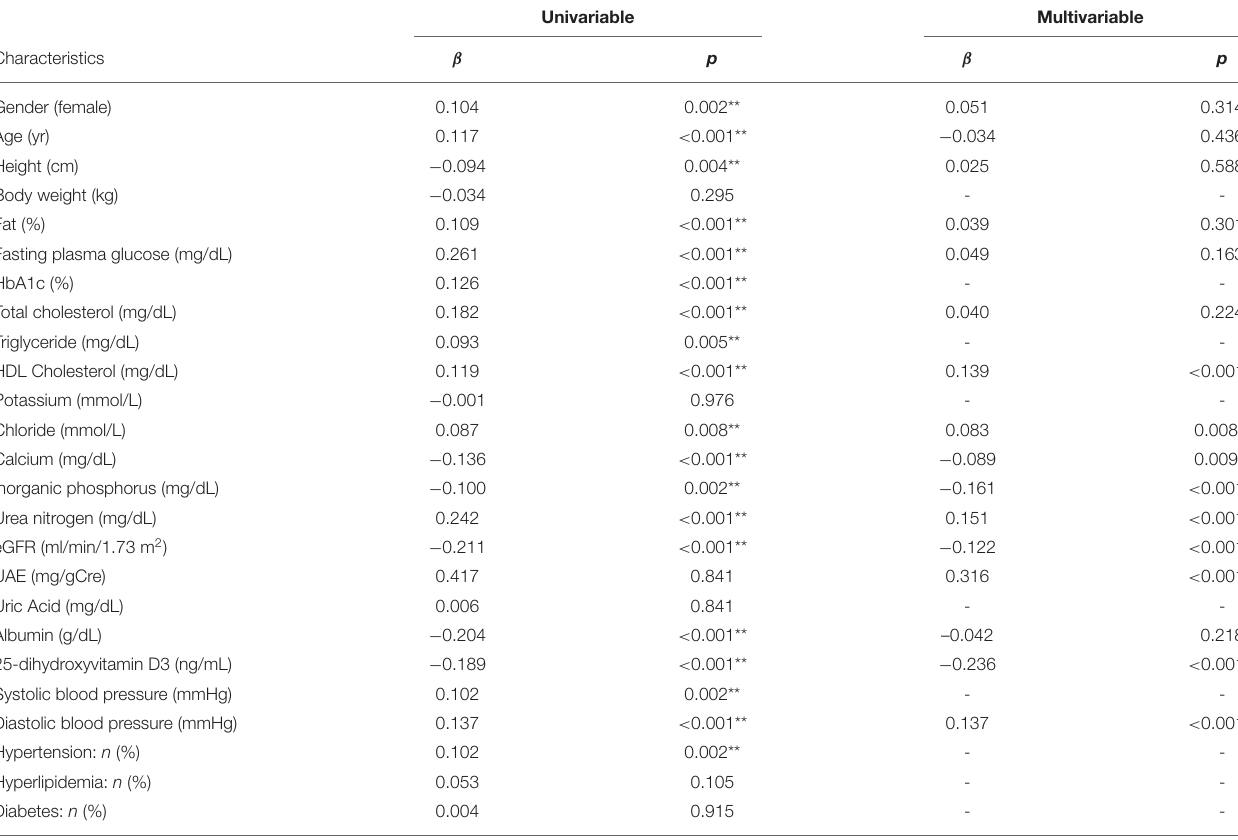
TABLE 2 | Correlations between serum intact PTH concentration and other clinical parameters. Univariable